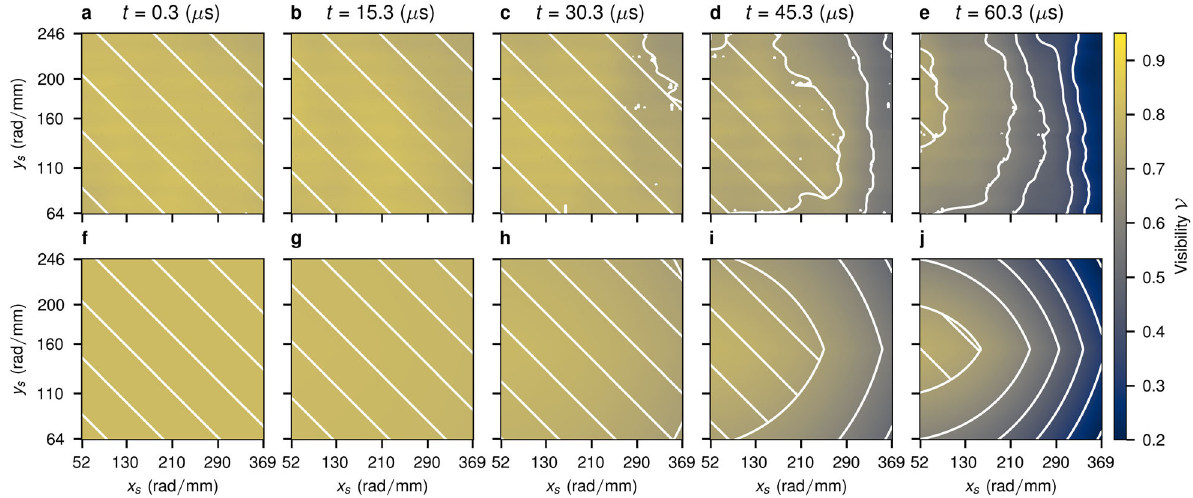
ffiffiffi p 2 (cid:5) 0 : 707 yielding CHSH violation.